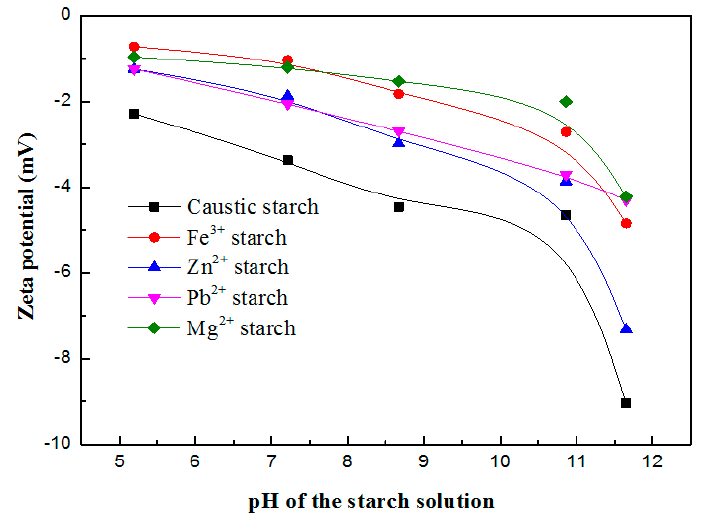
Figure 7. Zeta potential of various depressants (0.013 g/mL) as a function of pH.